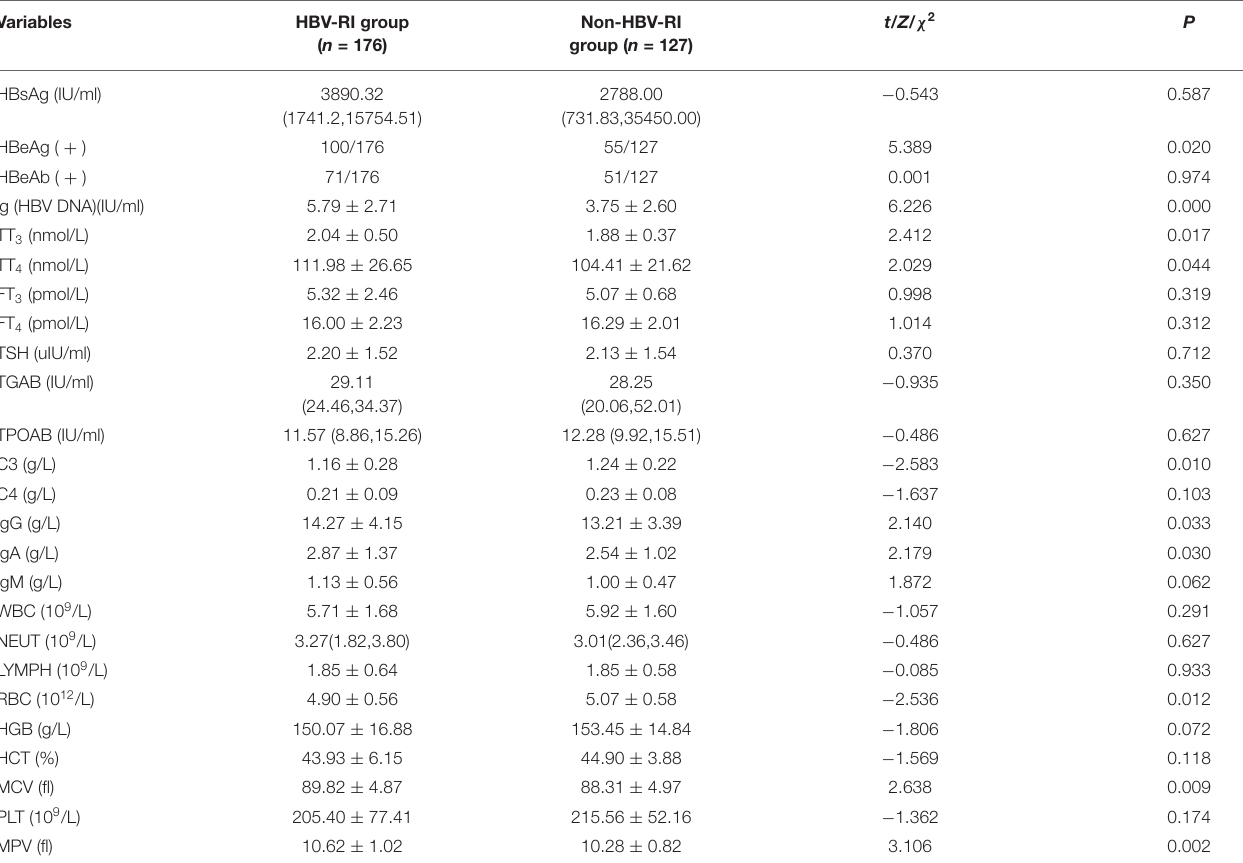
TABLE 2 | Parameters of virological, thyroid function, immune function, and blood routine test between the HBV-RI group and the non-HBV-RI group.